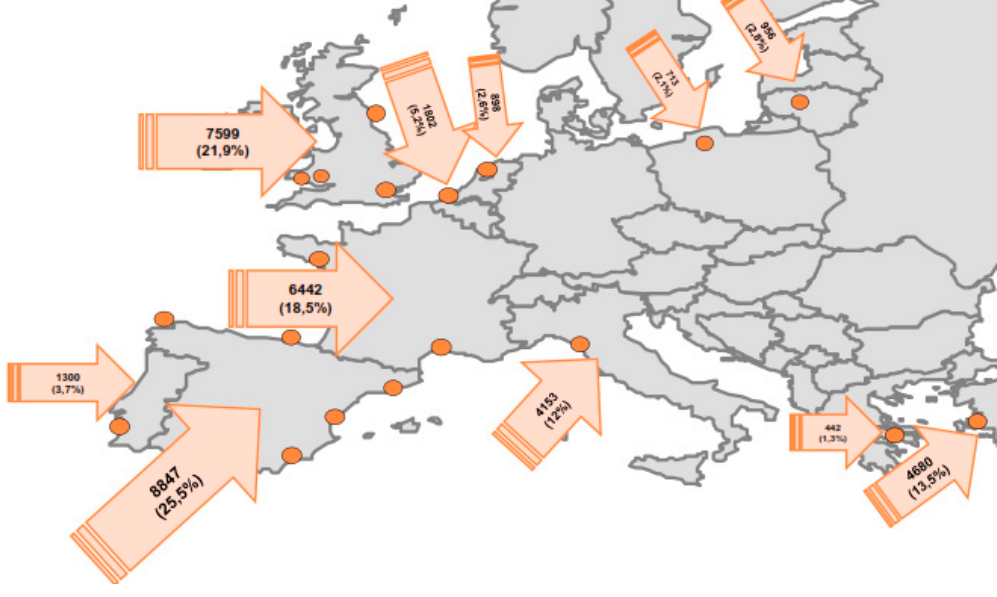
Figure 1. LNG imports in Europe in 2016 (thousand tones/percentage over total).